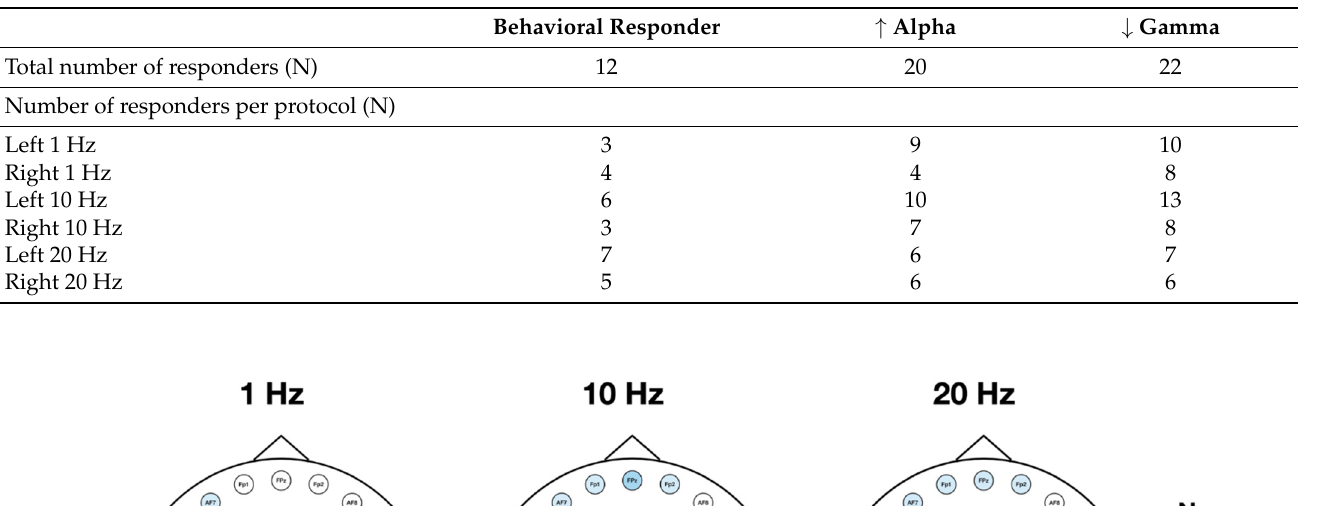
Table 3. Summary of behavioral and electrophysiological responder per rTMS protocol.